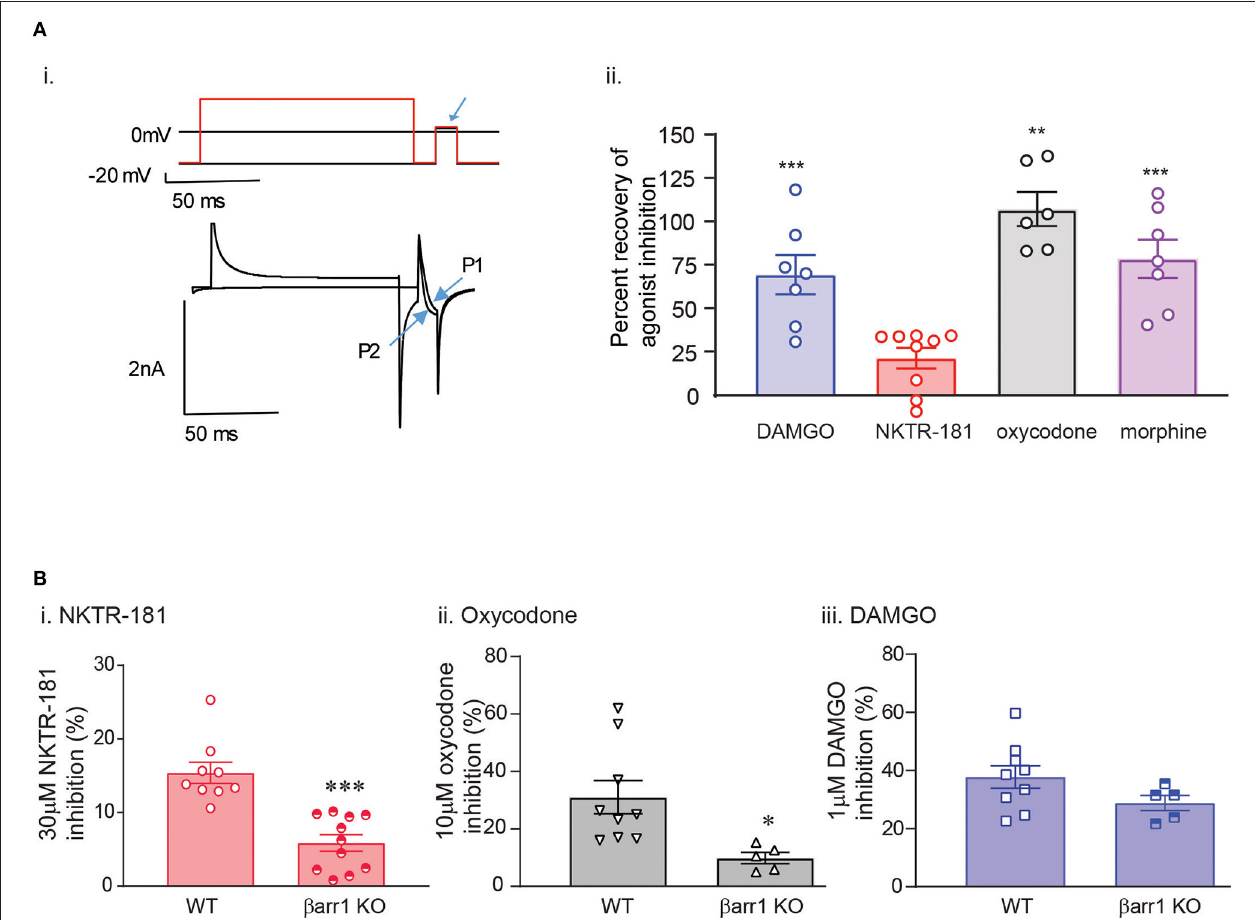
FIGURE 5 | The mechanism of NKTR-181 inhibition of VACCs is both different and similar to that of oxycodone. This was assessed by voltage-clamp patch-clamp recordings in adult DRG neurons. (A) Voltage-dependent inhibition . [A(i)] Agonist-VACC inhibition was first obtained and followed by a two-pulse protocol occurring over two sweeps in the presence of the agonist. In the first sweep (shown in black), there was no high voltage pre-pulse prior to the test pulse (highlighted by the blue arrow) and in the second sweep (shown in red) a high-voltage pre-pulse precedes the test pulse. The change in current amplitude in the absence and presence of the high voltage pre-pulse (P1 and P2) was used to assess the percent recovery of agonist inhibition by the pre-pulse. [A(ii)] This showed that oxycodone, DAMGO, and morphine, but not NKTR-181, predominantly inhibit VACCs by a voltage-dependent mechanism. **, *** p < 0.01, 0.001 vs. NKTR-181. (B) The role of the nonvisual arrestin isoform, β arr1 . Using DRGs lacking β arr1, we found that NKTR-181 [B(i)] requires this isoform for full VACC inhibition (*, ** p < 0.001 vs. WT). Oxycodone [B(ii)], but not DAMGO [B(iii)] also requires β arr1 for full VACC inhibition (* p < 0.05 vs. WT). Data are shown as mean SEM. Refer to Supplementary Table 2 for ±